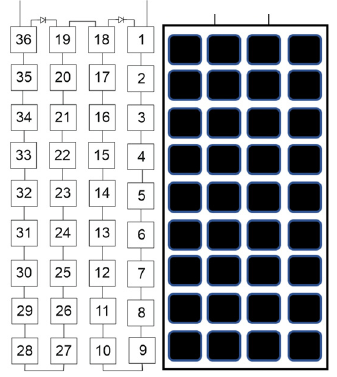
Figure 3. PV panel with two bypass diodes and 36 cells.